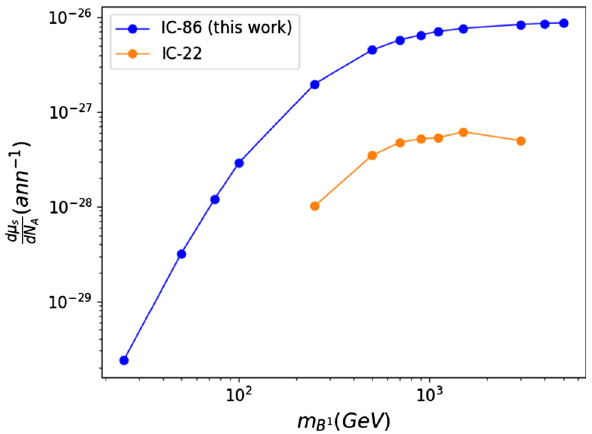
Fig. 4 Expected number of events in IceCube per annihilation as a function of B 1 mass. The blue dots (IC-86) show the result of this work (using Eq. (4) with the effective area of Ref. [18]), while the orange dots show the result using the effective area of the 22-string IceCube configuration(IC-22)[24],whichwasthebasisforthepreviousKaluza– Klein analysis [21]. Values calculated at the discrete mases denoted by the dots. Lines are just a linear interpolation between the dots to guide the eye